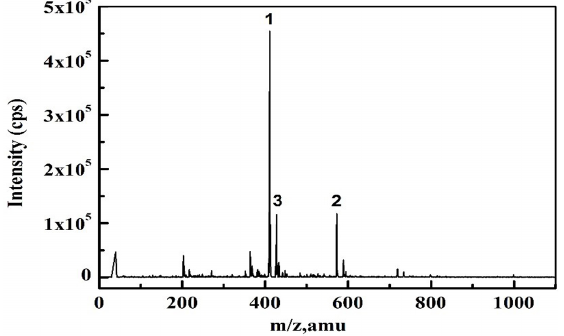
Fig.1. Qualitative analysis of extract of Gardenia fruit Reference solutions of geniposide and genipingentiobio- side were injected into API2000 separately for MS measurement. Geniposide (Mm=388.1) and